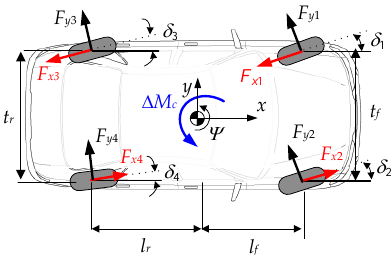
Figure 2. Coordinate system corresponding to tire forces and control yaw moment.